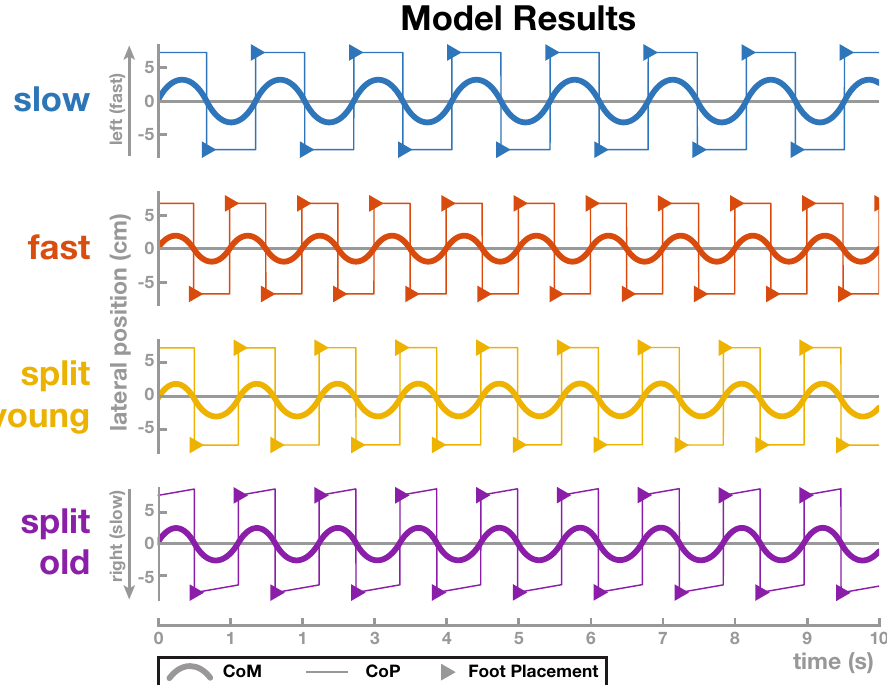
Figure 10. Single-link Inverted Pendulum Model: Results of the linearized single-link inverted pendulum models in the frontal plane. For each model, the thick solid line shows the CoM, the thin line the CoP and the triangles the foot placement for each step. The medium grey line indicates the mid-line between the left and right foot placements. The top two models show tied-belt walking in the slow (0.7 m s −1 , blue) and fast (1.4 m s −1 , red) baseline conditions. The bottom two models show split-belt walking with two different control approaches to stabilize the medial-lateral position on the treadmill. The “split young” model (yellow) uses asymmetric foot placement control, resulting in a systematic shift of the CoM relative to the mid-line between the feet. The “split old” model (purple) uses CoP modulation to shift the CoM to the left throughout each step, resulting in symmetric foot placement, but likely requiring active muscle